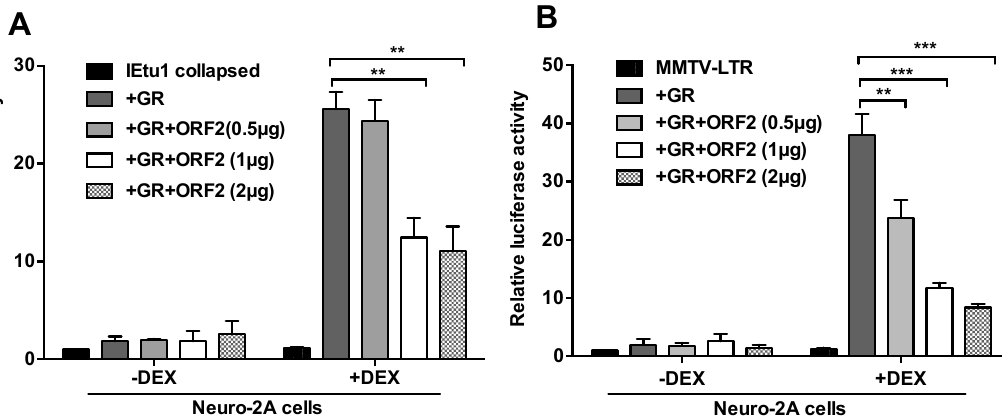
Figure 1. Open reading frame 2 (ORF2) inhibits glucocorticoid receptor (GR) and dexamethasone (DEX)-mediated trans- activation of stress-inducible promoters. Panel ( A ): Neuro-2A cells were transfected with the IEtu1 collapsed promoter construct containing the firefly luciferase reporter gene (0.5 µ g), GR expression plasmid (1.0 µ g), and ORF2 expression plasmid (0.5, 1.0 or 2.0 µ g). Panel ( B ): Neuro-2A cells were transfected with the mouse mammary tumor virus long terminal repeat (MMTV-LTR) promoter construct (0.5 µ g) and wt ORF2 expression construct (0.5, 1.0, or 2.0 µ g). All transfections contained a plasmid that expresses Renilla luciferase (0.05 µ g). To maintain the same amount of DNA in each sample, an empty vector was included in certain samples. Cells were incubated with 2% stripped fetal bovine serum (FBS) 24 h after transfection and as denoted certain cultures treated with DEX (10 µ M). At 48 h after transfection, cells were harvested, and protein lysate subjected to a dual-luciferase assay. The results are the average of three independent experiments and error bars denote the standard error. The student’s T test was used for statistical analysis: ns, not significant; **, p < 0.01; ***, p < 0.001.